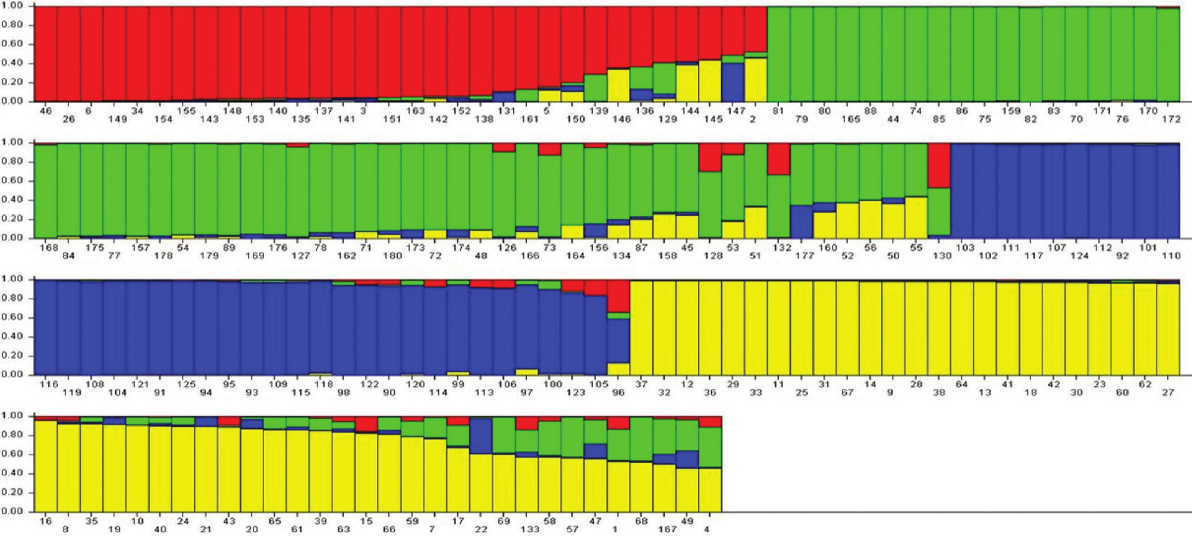
Figure 3 - Representation of the core collection according to the Bayesian analysis of the program Structure. The accessions evaluated were divided into four groups (K = 4). The names of the genotypes are given in Table S2 (The numbers correspond to the names of the genotypes). The red color corre- sponds to Groups 1, color Green corresponds to Group 2, color Blue corresponds to Group 3 and color Yellow corresponds to Group 4.